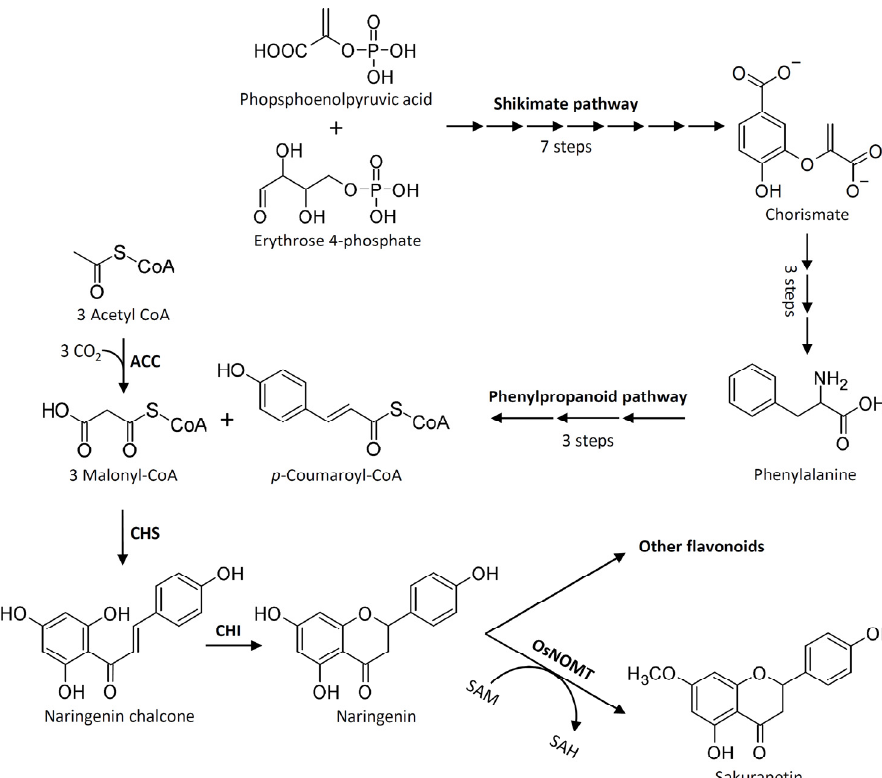
Figure 11. Biosynthesis of sakuranetin. ACC: acetyl-CoA carboxylase (EC 6.4.1.2); CHI: chalcone isomerase (EC 5.5.1.6); CHS: chalcone synthase (EC 2.3.1.74); OsNOMT: naringenin 7-O-methyltransferase (EC 2.1.1.232); SAH: adenosyl-L-homocysteine; SAM: S-adenosyl-L-methionine. Multiple arrows indicate multiple biosynthetic steps, while direct synthesis is indicated by single arrows.